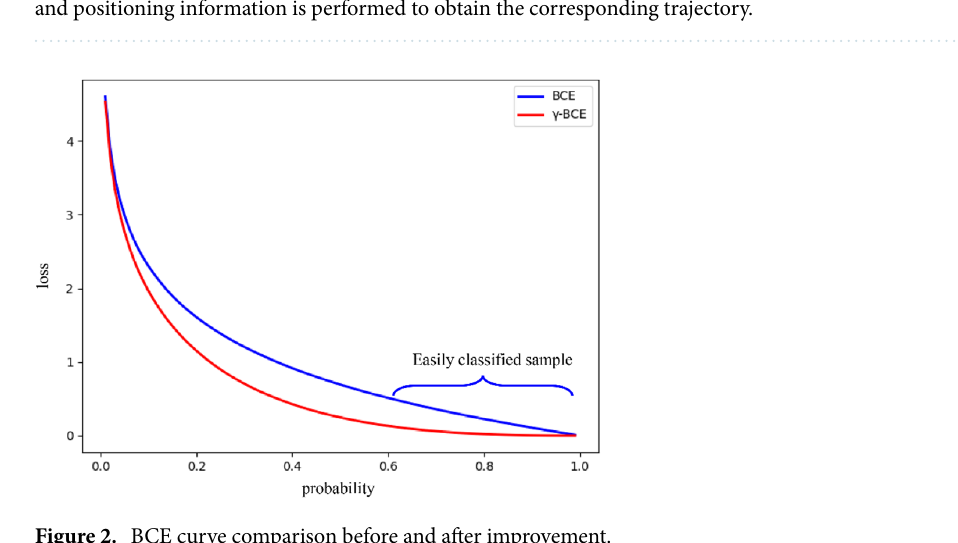
Figure 2. BCE curve comparison before and after